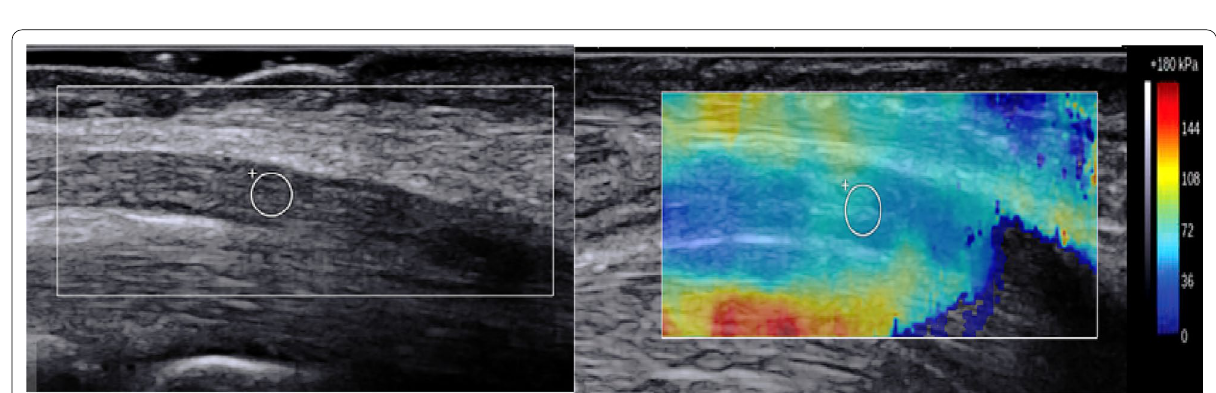
Fig. 6 A 48-year-old male patient with severe grade of carpal tunnel syndrome by electrophysiological diagnostic studies. ( Left ) High-resolution conventional B-mode ultrasound showed thickened median nerve with increased CSA (13.2 mm 2 ) and calculated wrist/forearm ratio (2.7). ( Right ) Shear-wave elastography of the median nerve displayed increased mean median nerve stiffness value